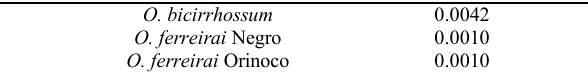
Table 2. Table of intraspecific and intragroup K2P distances (Kimura, 1980) observed in the two species of Osteoglossum and the Negro and Orinoco River populations of O. ferreirai